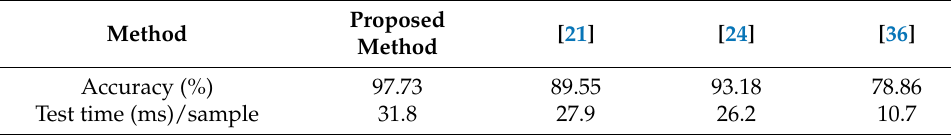
Table 8. Comparison of the test results of different